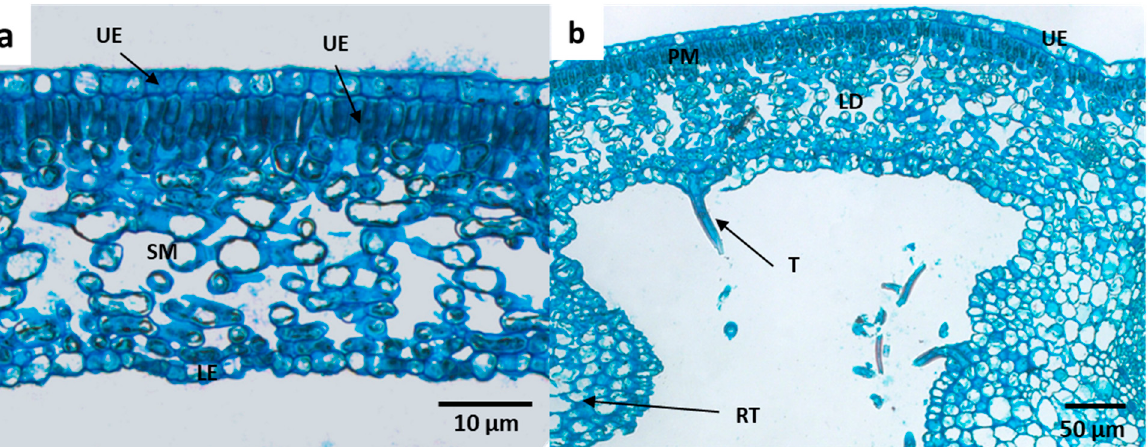
Figure 4. Comparison of domatial and non-domatial tissue of the hair-tuft-type domatia of Roth- mannia globosa ; ( a ) non-domatial area, ( b ) domatial opening with trichomes. LD: leaf domatial tissue, LE: lower epidermis, MV: mid-vin, UE: upper epidermis, PM: palisade mesophyll layer, RT: rim tissue, SM: spongy mesophyll, and T: trichomes.